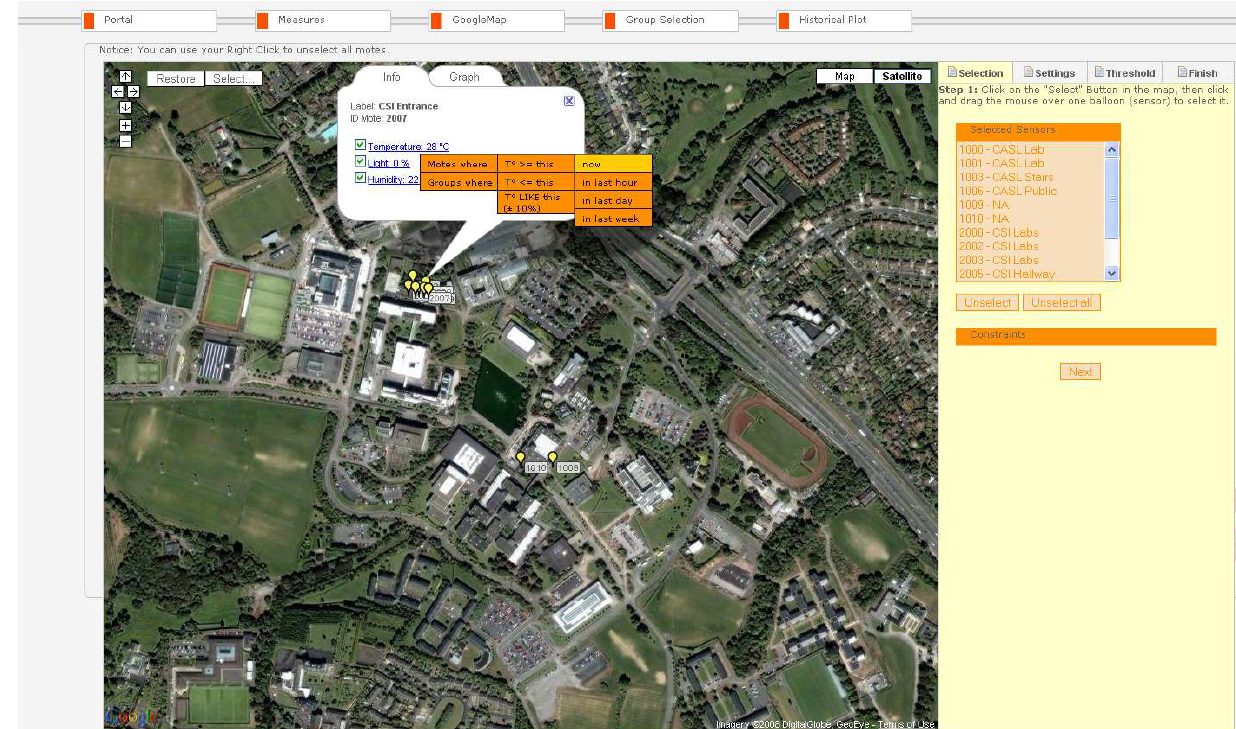
Figure 7. Map-based monitoring and node